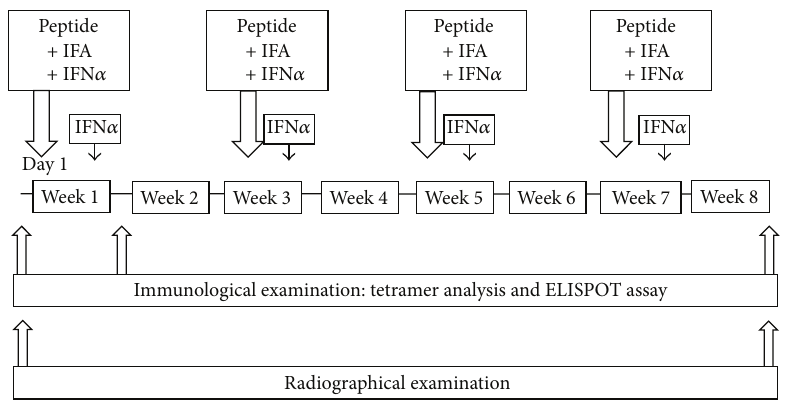
Figure 1: Protocol of Study 2. The protocol consisted of survivin-2B80–88 peptide, IFA, and IFN 𝛼 . IFA: incomplete Freund’s adjuvant; IFN: